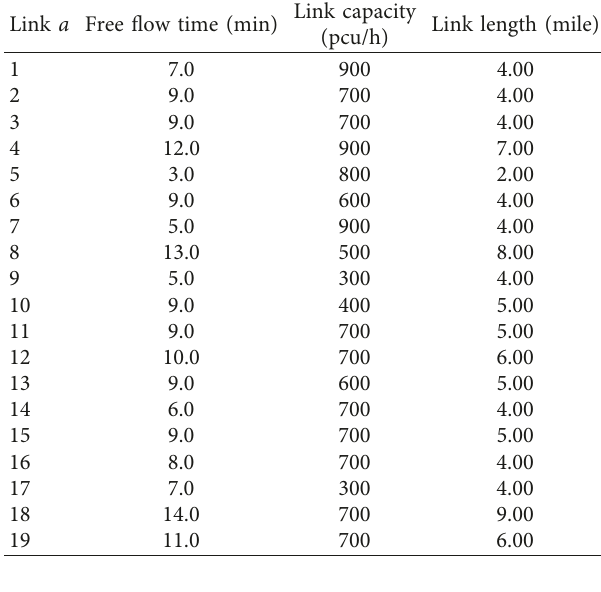
Figure 3: The Nguyen–Dupuis network. Table 1: Link parameters of the Nguyen–Dupuis network. Table 2: The link performances under the given transportation